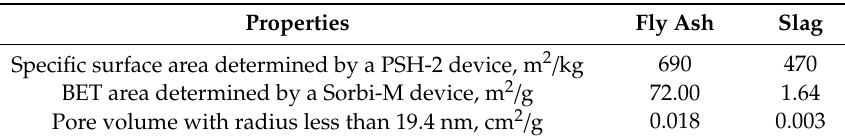
Figure 4. Fly ash (FA) and slag Particle size distribution. Table 6. Properties of finely ground fly ash and slag.